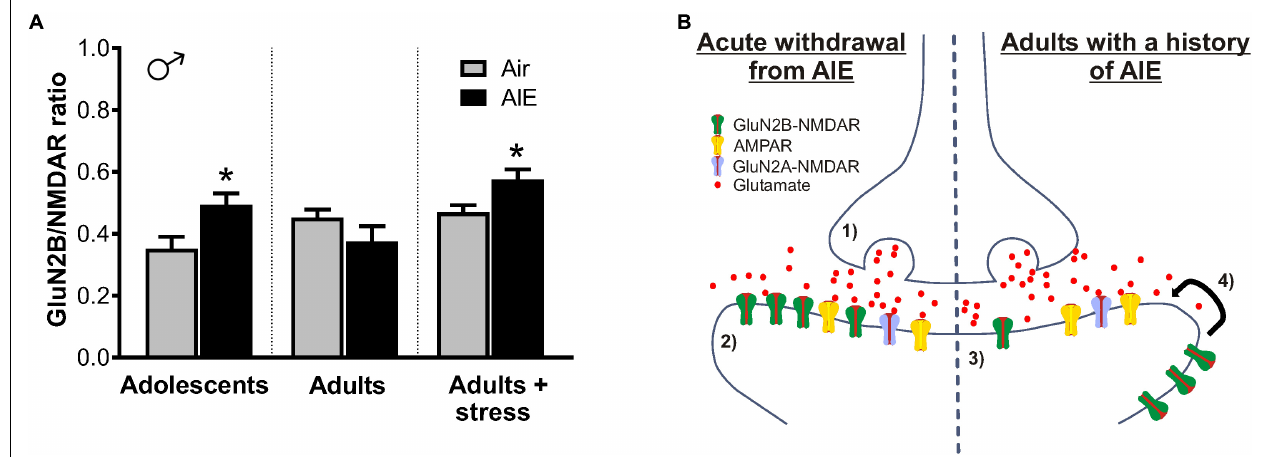
FIGURE 9 | Summary of AIE-induced changes in GluN2B-containing NMDARs of the male dlBNST and a proposed model of the synaptic mechanisms underlying these changes. (A) GluN2B inhibition (produced by Ro 25–6981) normalized to total NMDAR transmission. Symbols indicate significant differences between groups, as determined by an unpaired t -test, ∗ p < 0.05. Under basal conditions, adults with a history of AIE exhibited reduced GluN2B ( p = 0.1868)—a trend that was opposite to that seen immediately following AIE and in stressed adults with a history of AIE. (B) Proposed model of AIE-induced changes to synaptic GluN2B-containing NMDARs during acute and protracted withdrawal, as well as during adult stress. Acute withdrawal from AIE (1) enhances presynaptic glutamate release and (2) increases in the GluN2B-containing NMDARs at the postsynaptic density. The lateral movement of these GluN2B-NMDARs to extrasynaptic locations occurs during extended withdrawal from AIE (3). Stress during extended withdrawal triggers the retargeting of extrasynaptically located GluN2B-NMDARs to the synapse (4), revealing AIE-induced changes in GluN2B-NMDAR transmission and NMDAR